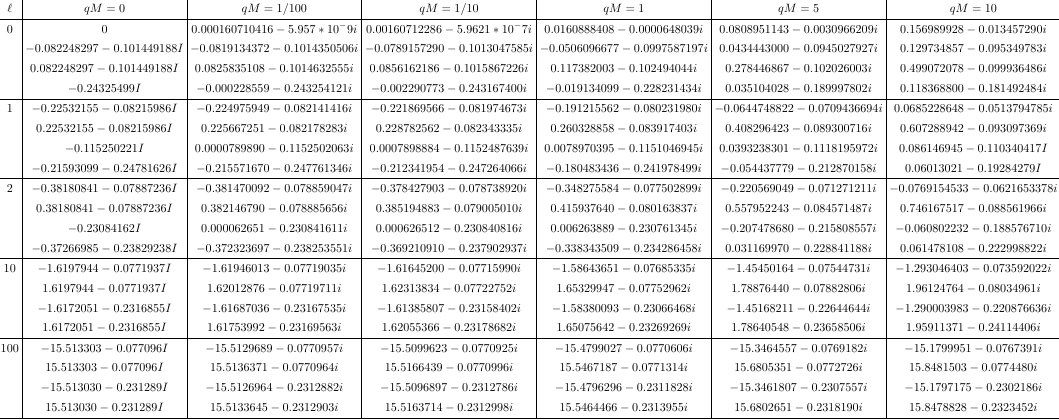
Table 4 . The QNFs ωM for massless charged scalar fields in the background of RNdS black holes with Λ M 2 = 0 . 04 , Q/M = 1 / 10 , and diferent values of ‘ .